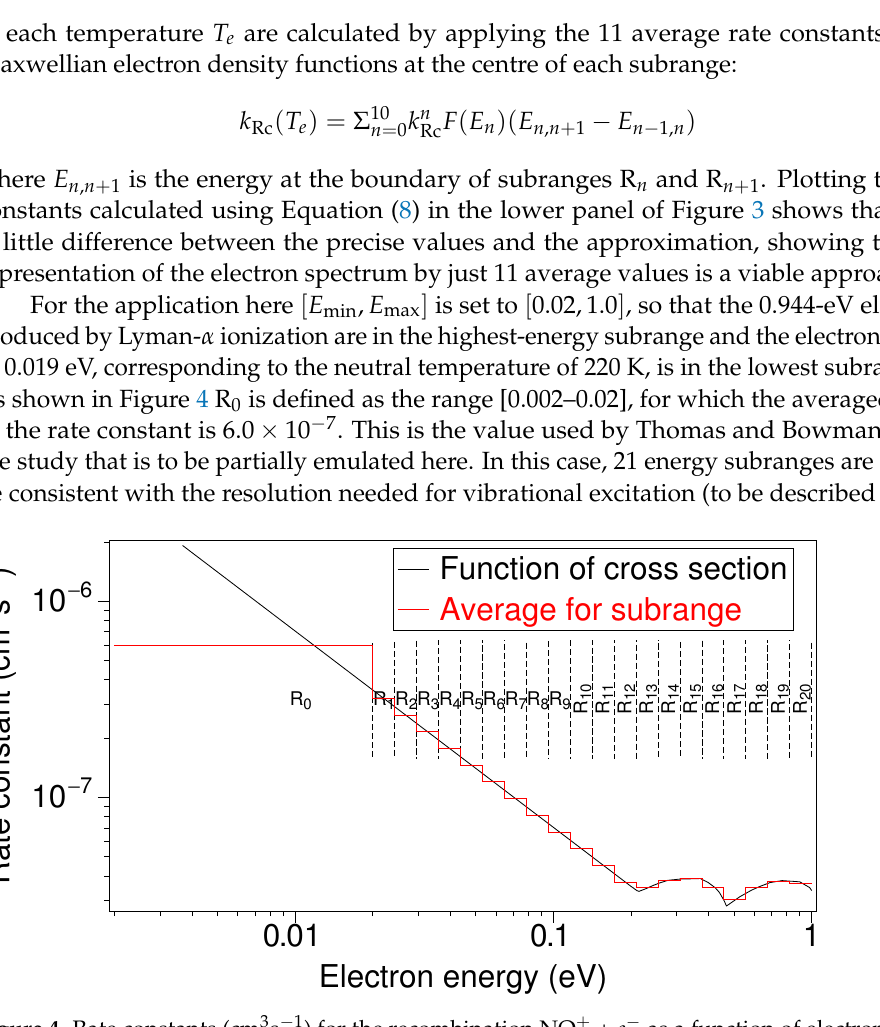
Figure 4. Rate constants (cm 3 s − 1 ) for the recombination NO + + e − as a function of electron energy (eV), as calculated from the cross sections of Walls and Dunn [19] (curve), with this function averaged over energy subranges (horizontal segments) for the parameters of the EI